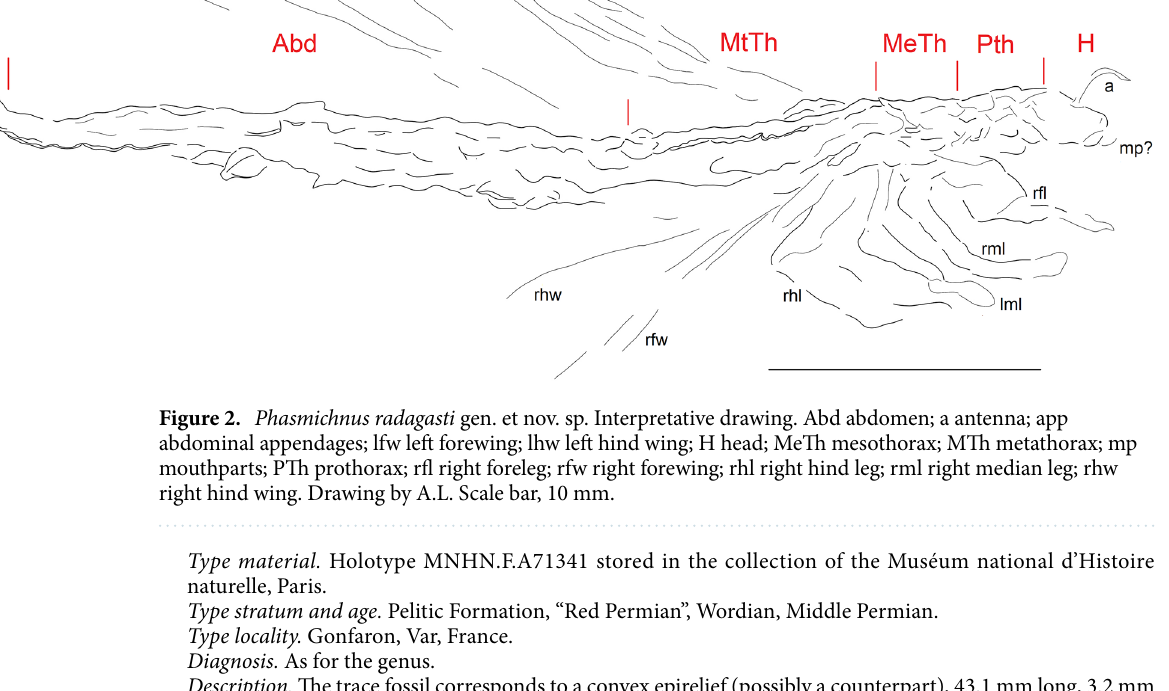
Type stratum and age. Pelitic Formation, “Red Permian”, Wordian, Middle Permian. Type locality. Gonfaron, Var, France. Diagnosis. As for the genus. Description. The trace fossil corresponds to a convex epirelief (possibly a counterpart), 43.1 mm long, 3.2 mm wide; with three distinct tagmata impressions; anterior tagma (H), 2.9 mm long and oval with a fine impres- sions ‘a’, curved forward, on top of ‘H’; thicker at its attachment points and tapering distally; at the bottom front of ‘H’, the impression ‘mp?’ elongated and curved upward in distal part; second tagma ‘Th’ 16.1 mm long, located behind ‘H’; ‘Th’ longer and thicker than ‘H’; ‘Th’ divided into three parts from front to back, their limits being determined by the positions of the legs and wings: first part, 3.2 mm long, appearing very short dorsally and carrying a pair of legs in its ventral part; second part, 7.3 mm long, very long and also carrying posteriorly a pair of legs and a pair of very long and wide structures (forewing tracks lfw and rfg); third part, 5.9 mm long, also very long, carrying one or two visible legs (only distal parts visible, their bases and femora being hidden by forewings) and a pair of hind wing tracks (lhw & rhw) quite distinct from forewing tracks, located just after level of bases of median legs; these wing structures being large, and covering at least 1/2 of total length of impression; third tagma impression ‘Abd’ the longest, 24.1 mm long, longer than ‘H’ and ‘Th’ combined, and of comparable thickness as ‘Th’, subdivided into a dorsal and a ventral parts; numerous indentations visible on it at fairly regular intervals (at least seven); no trace of dorsal or ventral appendages; a small structure ending in two points ‘app’ visible at apex of ‘Abd’.